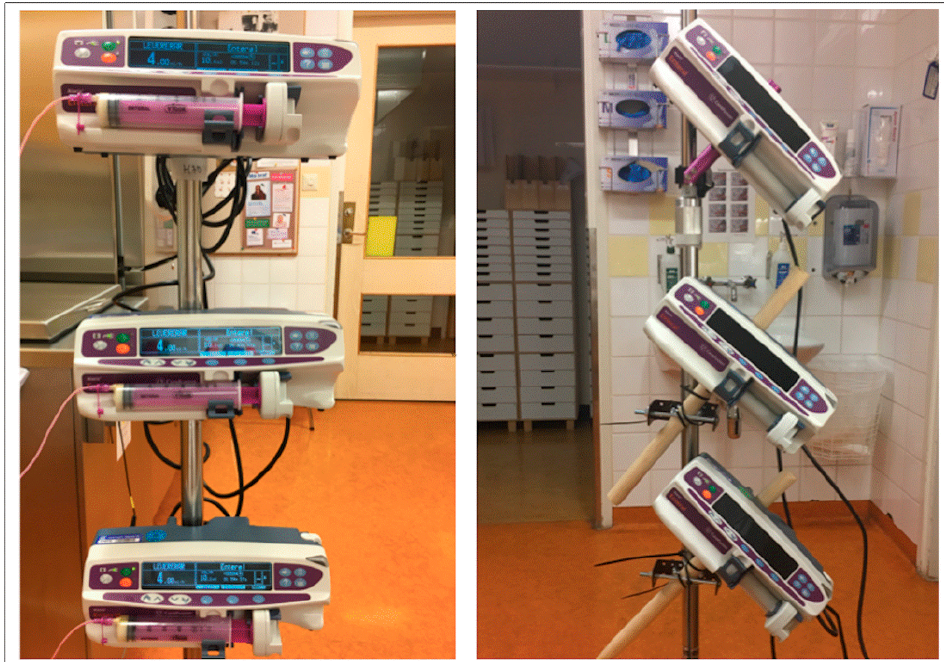
Figure 1. Horizontal and Tilted Pump Set Up. Photo by author. The NICU 95F only had one 45-degree pole clamp. Two more pole clamps were constructed for this study (Figure 2).